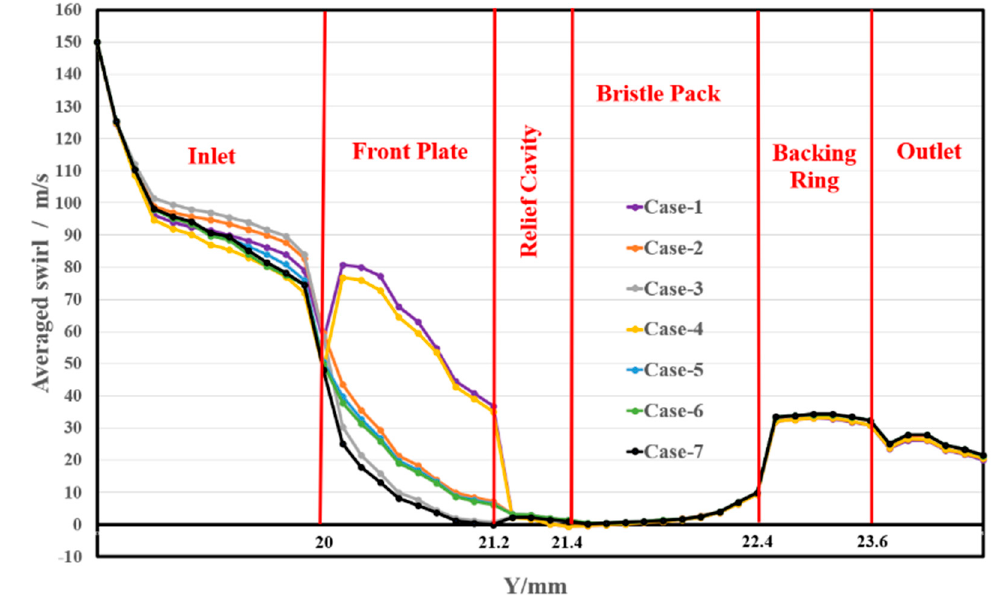
Figure 13. Swirl velocity variation for different models. Table 2. Averaged swirl velocity on the plane 0.2 mm upstream of the bristle